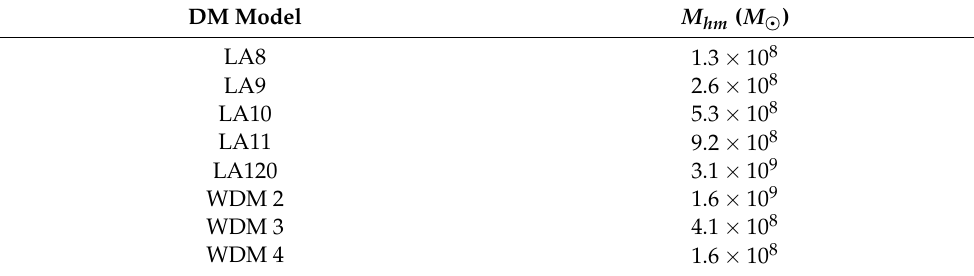
Table 1. Half-mode mass ( M hm ) for each Dark Matter model analysed in this